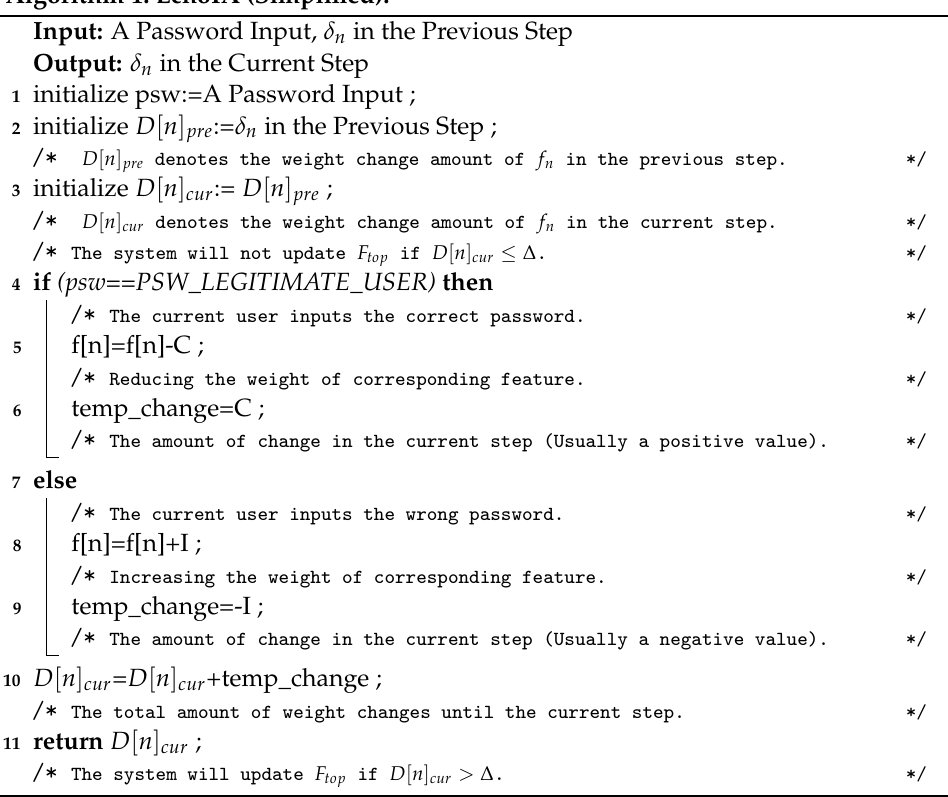
Algorithm 1: EchoIA